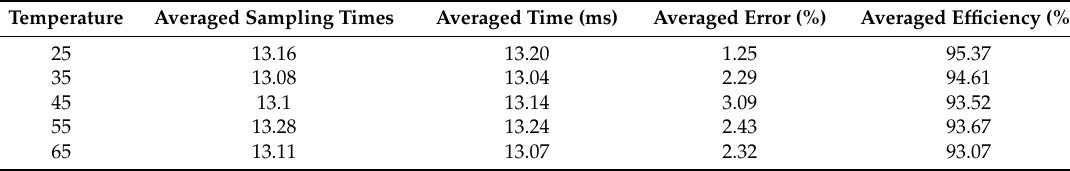
Table 12. Performance of the proposed MFA at different